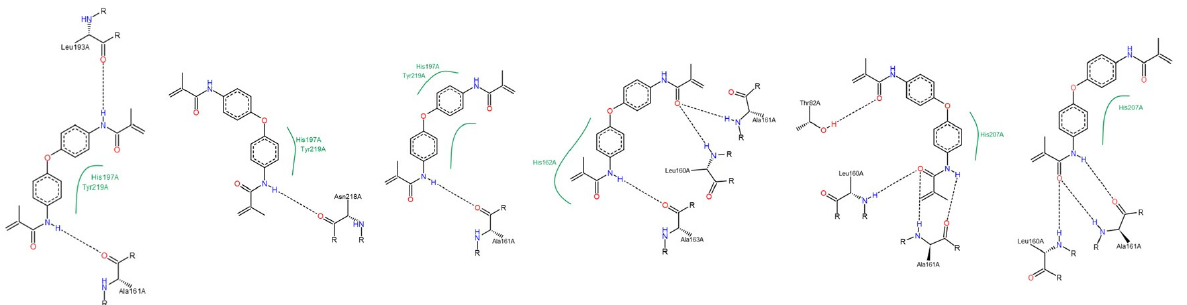
Figure A17. Interactions between compound C and MMP-2, by PoseView calculations.